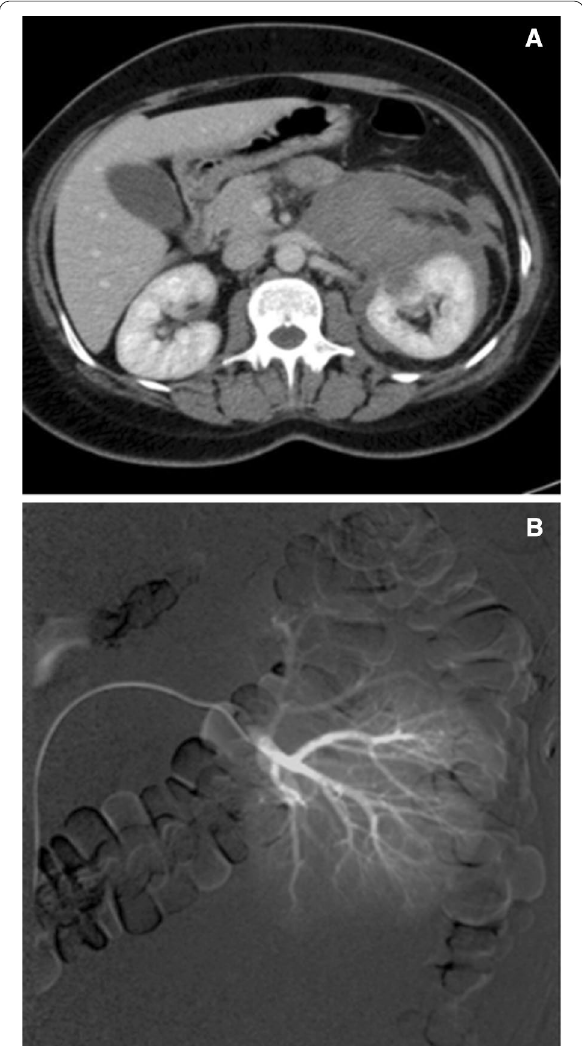
Fig. 4 Axial non‑contrast computed tomography imaging of a 45‑year‑old male patient with a perinephric haematoma after percutaneous nephrolithotomy showing a large perinephric haematoma related to the left renal upper pole associated with parenchymal laceration ( A ). Selective left renal angiography using a cobra head catheter revealed normal intrarenal arteries with no vascular lesions ( B